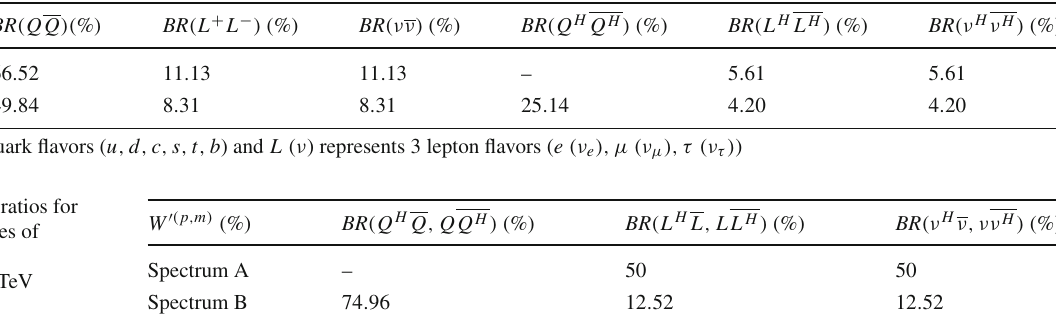
Table 2 Branching ratios for different decay modes of Z (cid:2) with 1 . 5 ≤ m Z (cid:2) ≤ 3 TeV Z (cid:2)